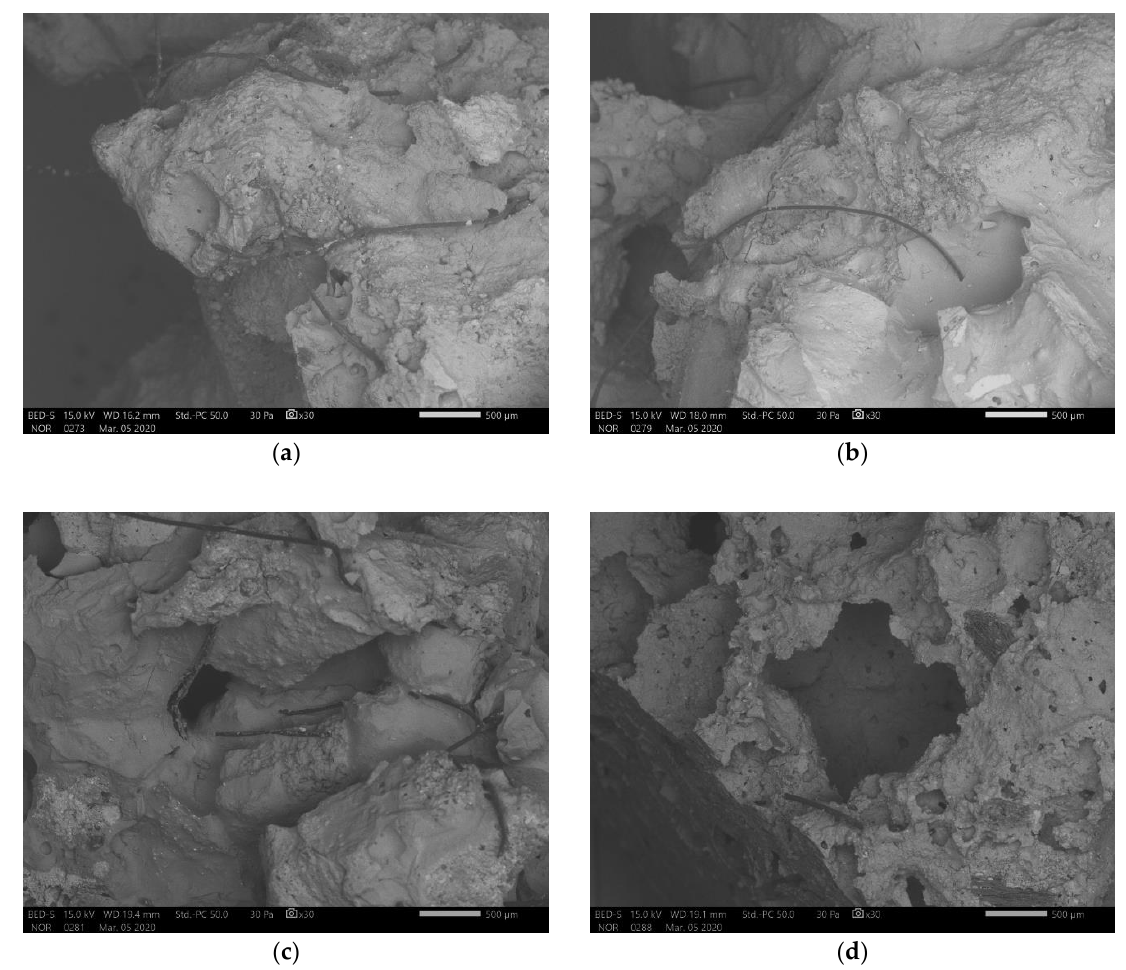
Figure 11. SEM micrographs of unpolished alkali activated materials (AAM) after bending strength measurement from precursor sieved ( a ) above 4 mm, ( b ) between 2 mm and 4 mm, ( c ) between 1 mm and 2 mm and ( d ) below 1 mm.